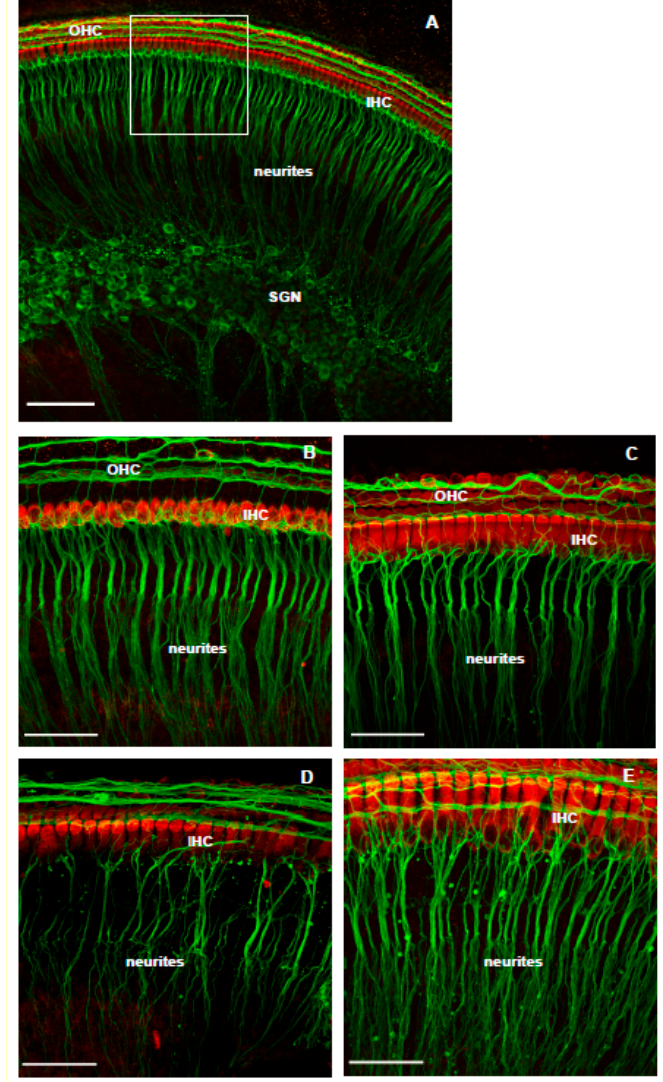
Figure 3. The effect of istradefylline treatment on cochlear explants exposed to excitotoxic injury. ( A ) P6 Wistar rat cochleae labelled with Myosin VIIa (red; sensory hair cells) and β -tubulin (green; spiral ganglion neurons and their neurites) in normal culture medium at low magnification (20×). The white box indicates the region of interest. ( B ) Cochlea cultured in normal medium (n = 7) and ( C ) culture medium containing istradefylline (n = 5). ( D ) Rat cochlea 18 h after NK-induced injury (n = 7) and ( E ) with istradefylline treatment (NK + Istradefylline; n = 10). IHC, inner hair cells; OHC, outer hair cells; SGN, spiral ganglion neurons. Images are representative of the number of experiments shown in brackets for each group. Scale bars, ( A ) 100 µ m; ( B – E ) 50 µ